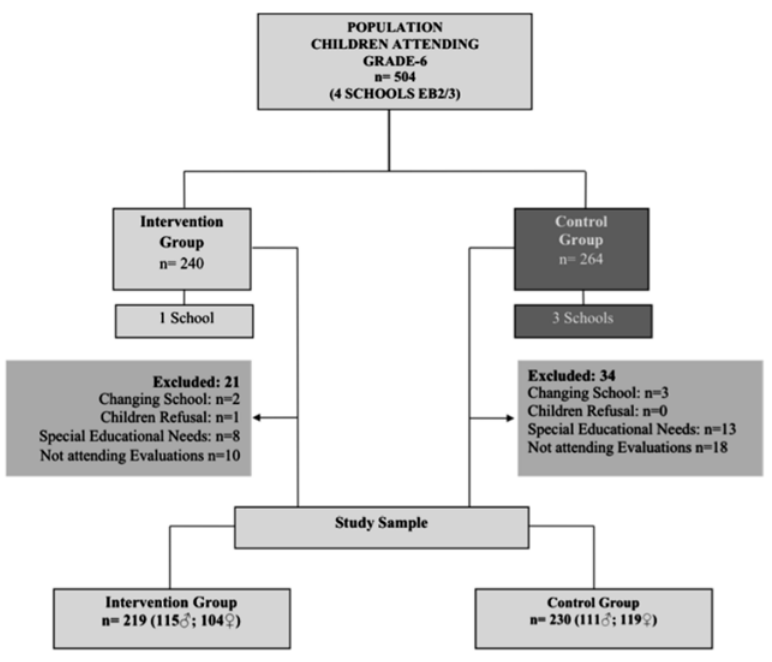
Figure 1. Flow chart of recruitment and sample selection.